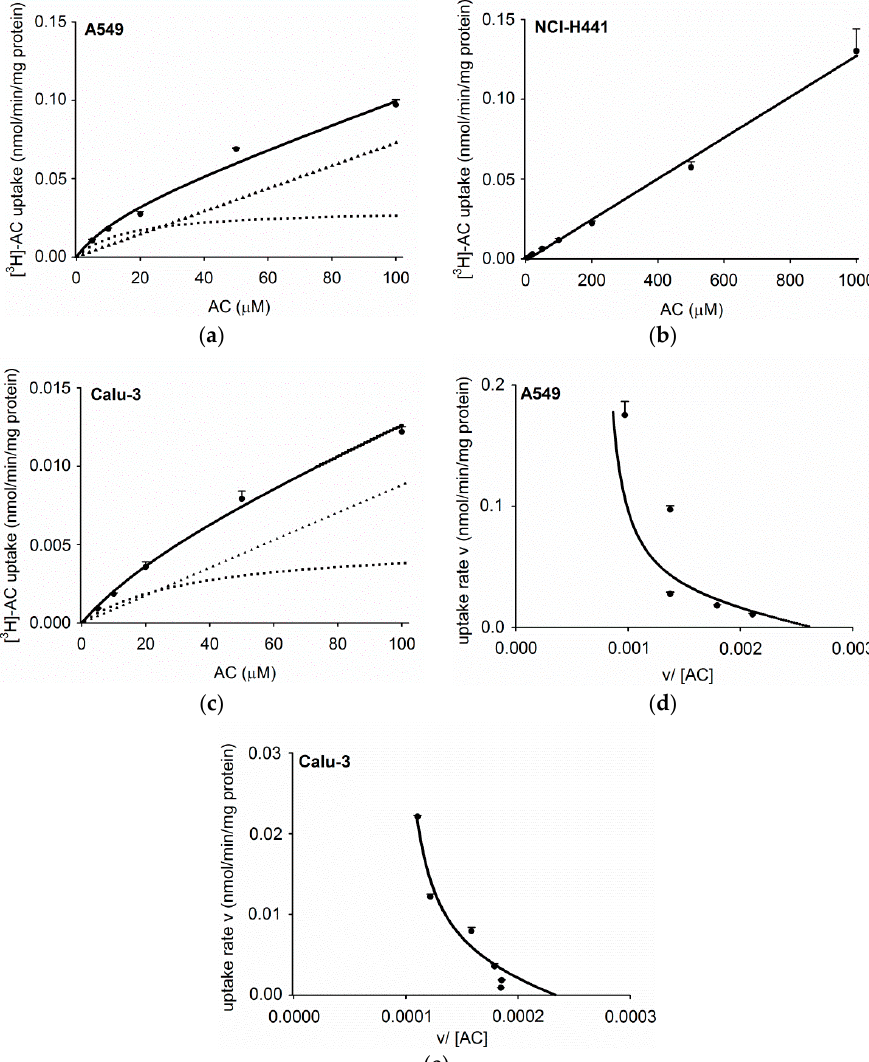
Figure 2. Concentration dependence of [ 3 H]-AC uptake by ( a ) A549, ( b ) NCl-H441, and ( c ) Calu-3 epithelial cells for 20 min. Furthermore, [ 3 H]-AC uptake was analyzed by means of Eadie–Hofstee equation in the case of ( d ) A549 and ( e ) Calu-3 cells, respectively: v, uptake rate (nmol/min/mg protein); [AC], acetyl- L -carnitine concentration in µM; v/[AC] (µL/min/mg protein). Total (solid line), saturable part (broken line), and non-saturable part (triangle) of [ 3 H]-AC uptake is shown up to 100 µM, calculated by using the kinetic parameters K m , V max , and K d for ( d ) A549 and ( e ) Calu-3 epithelial cells. These results were obtained by subtraction of [ 3 H]-AC uptake at 4 ◦ C as the non-specific component from the total uptake. Data represent mean ± SD ( n =